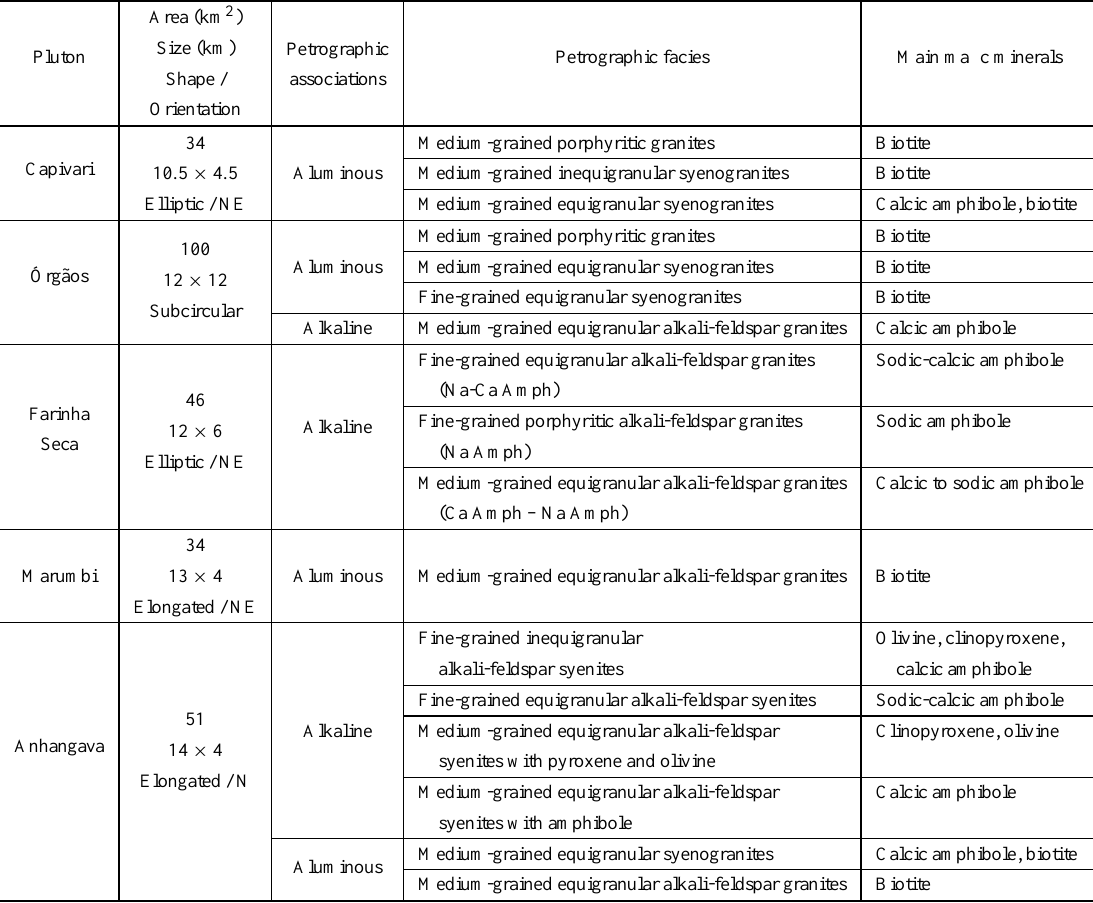
Main geological and petrographic characteristics of the five plutons in the Serra da Graciosa r